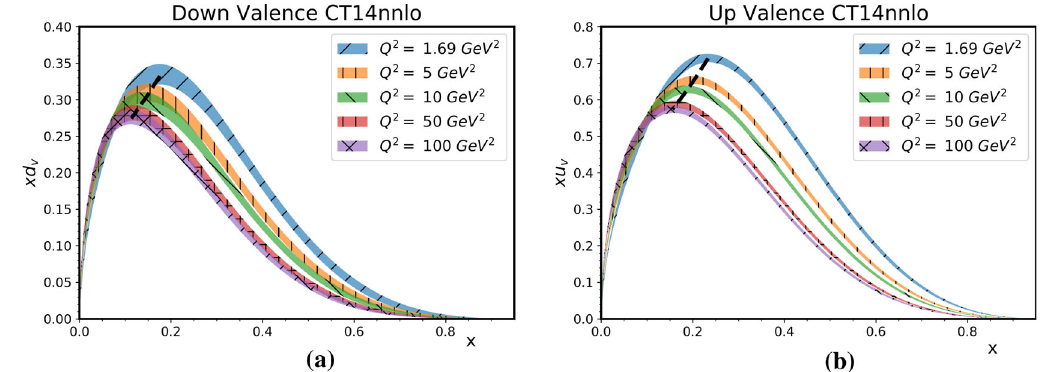
Fig. 3 The up and down valence PDFs (left) and x weighted PDFs (right) at Q 2 = 4 GeV 2 . The 68% confidence level error bands for PDF parametrization are shown. The PDF sets CJ15nlo and NNPDF3.1-nnlo